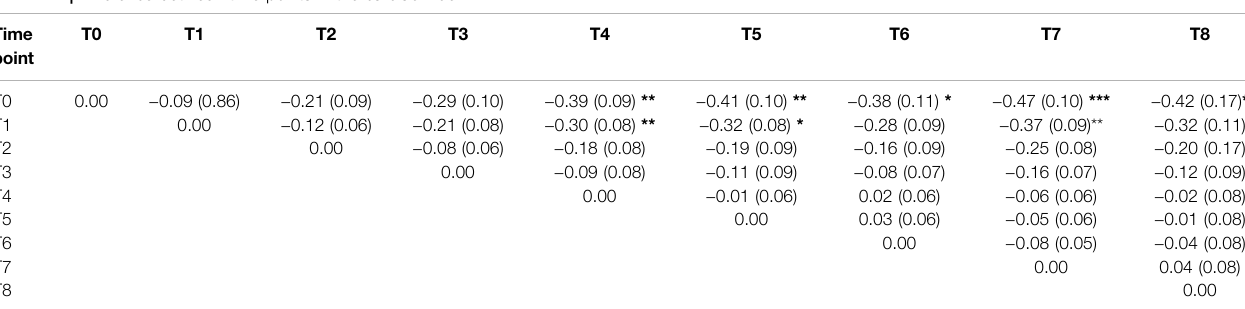
TABLE 4 | Difference between time points in the cardiac index.